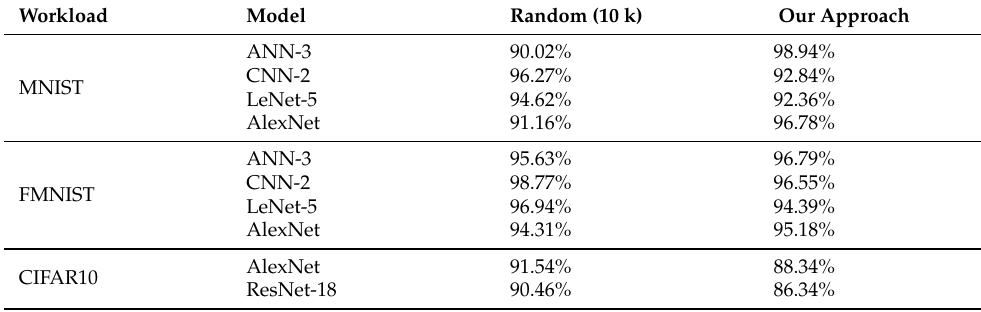
Table 4. Fault coverage achieved using 10,000 images from the training set versus our approach.